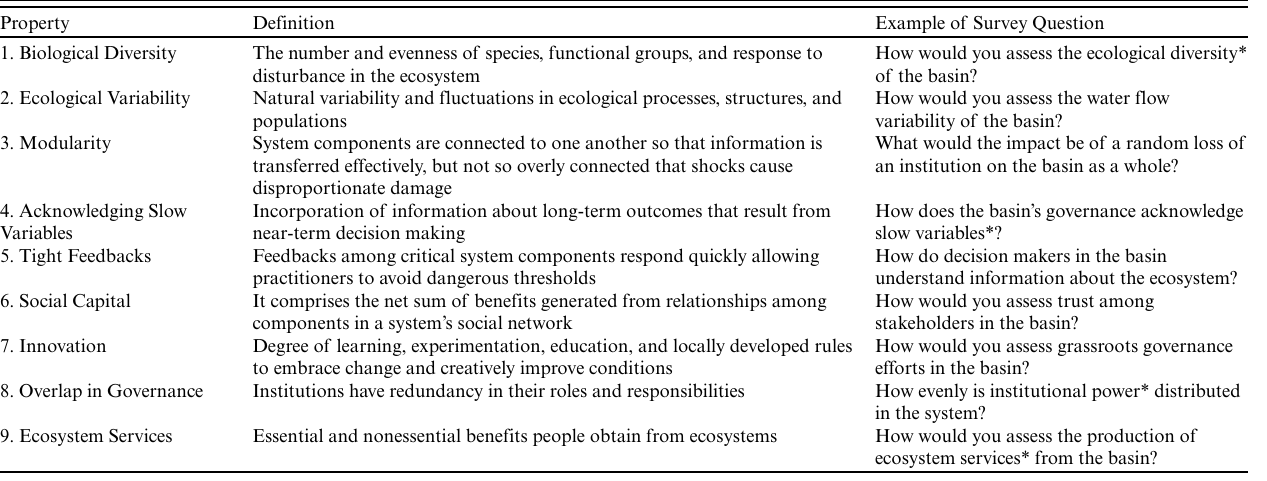
Table 1 . The nine properties of a resilient social-ecological system from Walker and Salt (2006), along with their definitions (adapted from Allen et al. 2016), and a survey question designed to address that property (asterisks represent definitions given to participants via